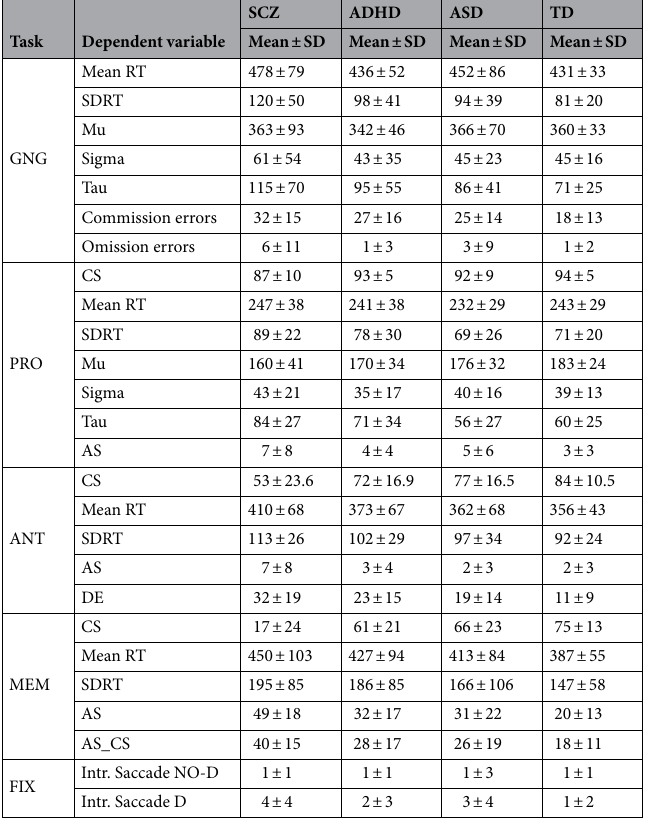
Table 2. Descriptive statistics. Mean RT mean response time, SDRT standard deviation of response time, CS correct responses, AS anticipatory saccades, DE direction errors from the ANT task, AS_CS correct anticipatory saccades from the MEM task, Intr. Saccade NO‑D intrusive saccades from block without distractors of the FIX task, Intr. Saccade D intrusive saccades from block with distractors of the FIX task. Column for each group reports Mean ± SD (standard